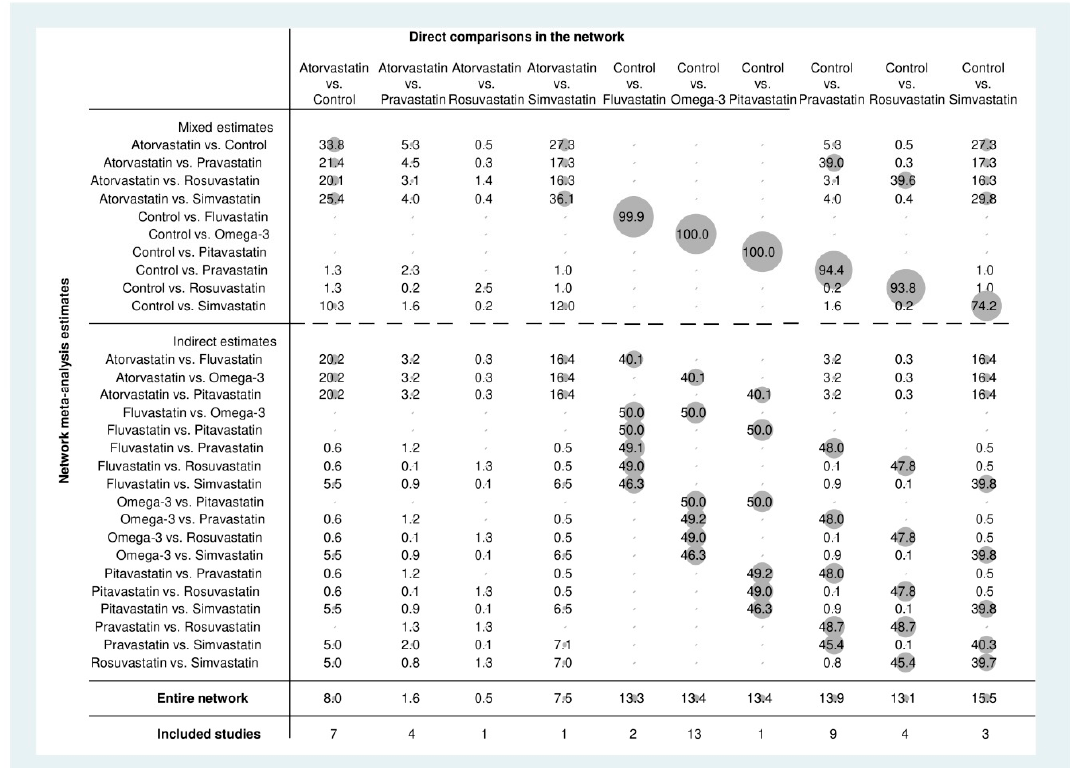
Figure A7. Contribution plot for the stroke network. The size of the square is weighted as the percentage (as number) of the contribution of the direct estimate (horizontal axis) to the network estimate (vertical axis).